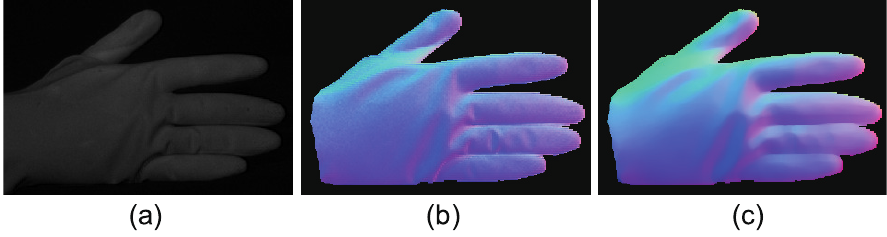
Figure 25. The results for hand with glove. Estimated surface normal [pose 1]: ( a ) One of the seven channel images, ( b ) estimated surface normal [naive color photometric stereo], and ( c ) estimated surface normal [our method]. Both color photometric stereos can estimate the surface normal of the dynamically deforming